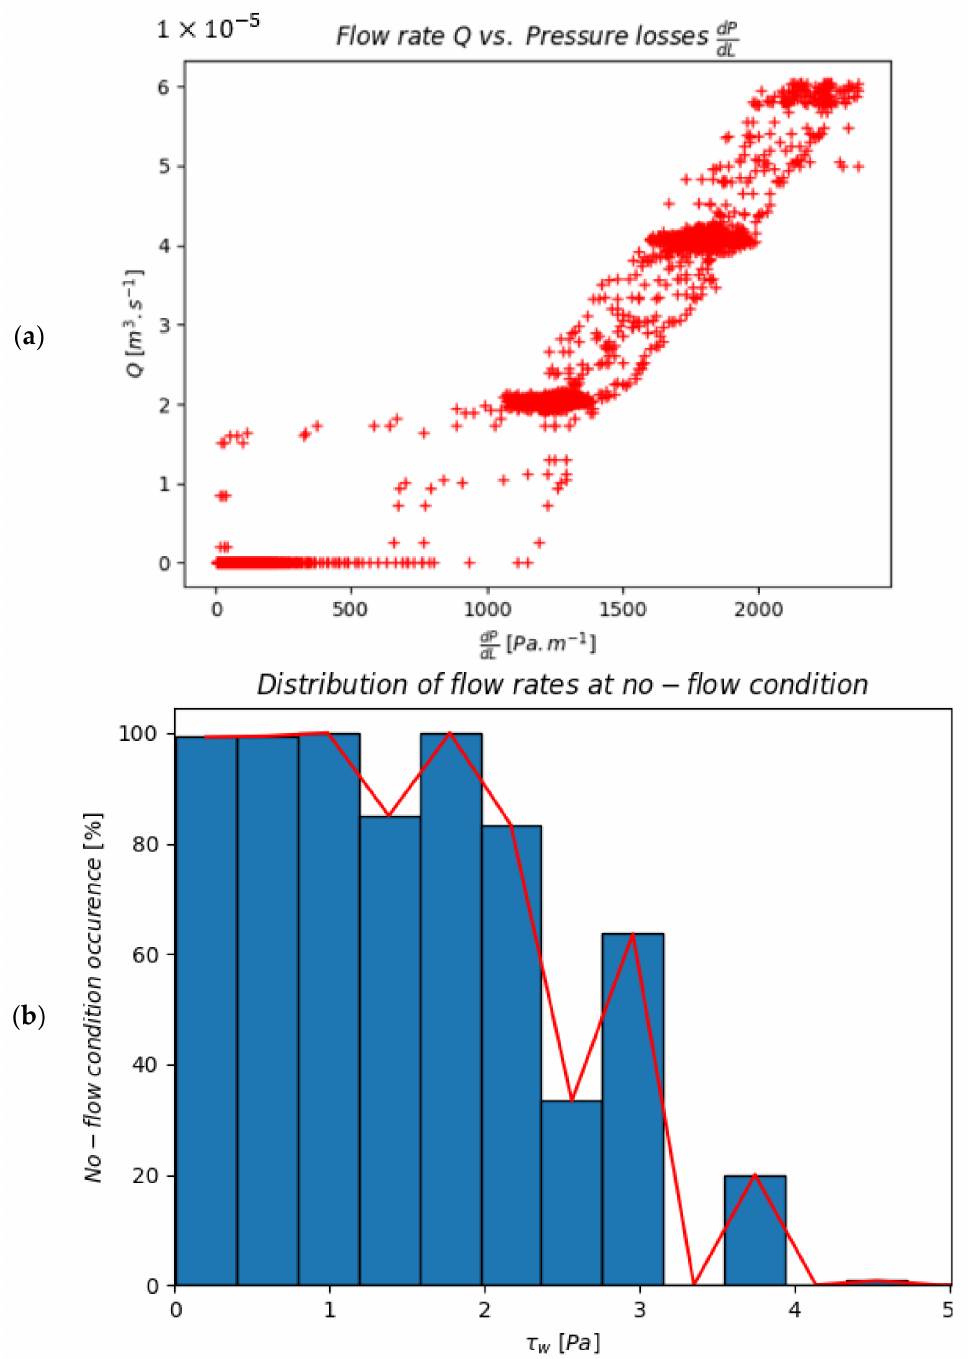
Figure 4. Estimations of τ γ looking at pressure losses at a low flow rate. ( a ) Pressure losses at a low flow rate are not steady since it depends on the flow history of the fluid. ( b ) This histogram shows the percentage of occurrences of non-flowing state at a given wall shear stress τ w up to the stress overshoot